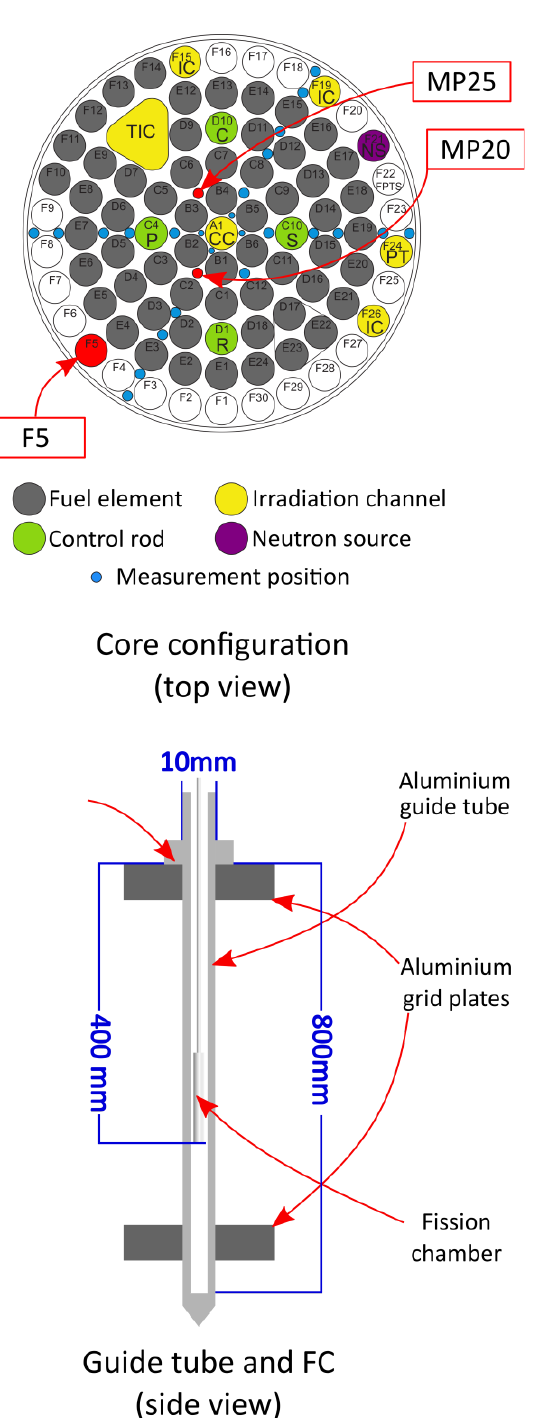
Fig. 3. Top: Schematic view of the JSI TRIGA reactor core configuration (top view). Bottom: Schematic view of a fission chamber and a guide tube located between the reactor support plates.